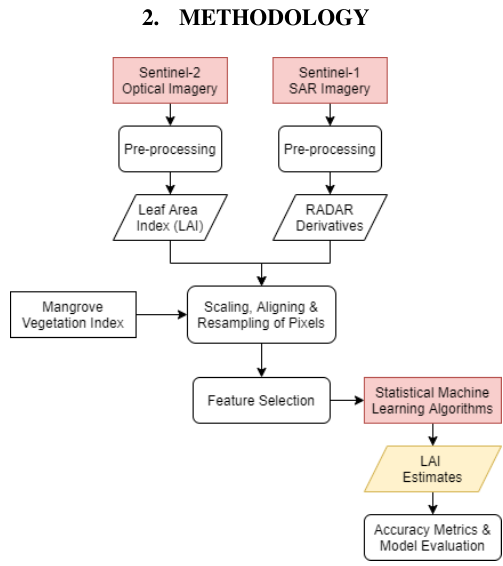
Figure 2. Methodology overview for generating a model that is aimed to establish a relationship from LAI-derived data from Sentinel-2 with RADAR derivatives extracted from Sentinel-1